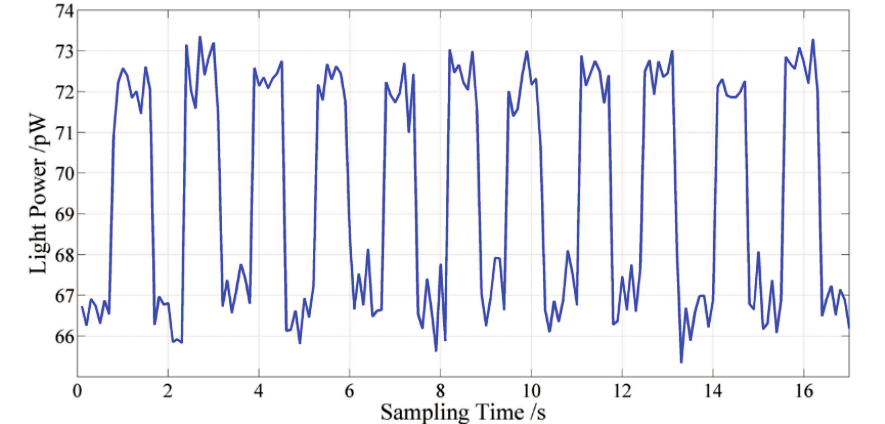
Figure 10. Experimental result of the optical power resolution of the acquisition circuit